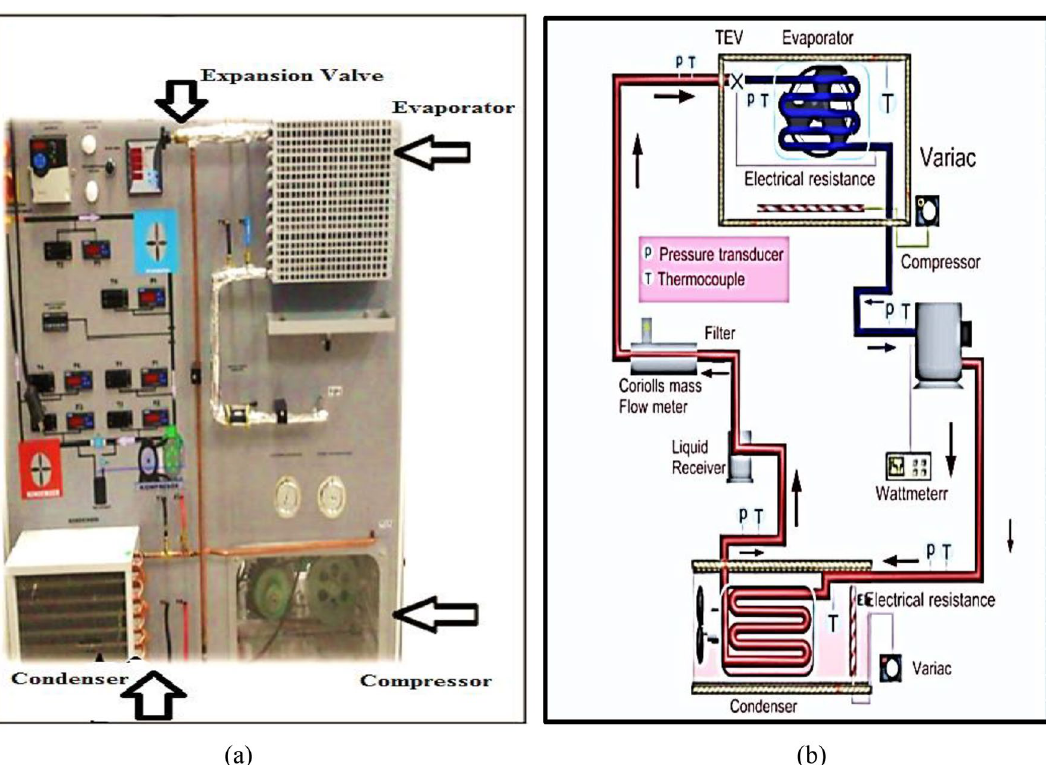
Figure 2. ( a ) Experimental work and its corresponding parameters and ( b ) schematic diagram of the experiment drawn by Mechanical Engineer Taher Abdaladeem